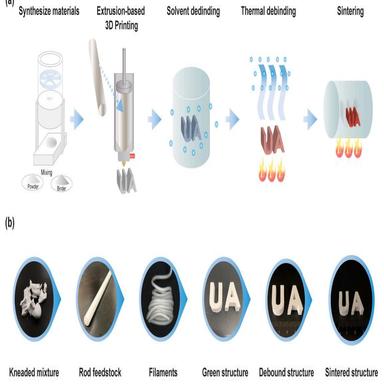
Schematic of entire ceramic additive manufacturing process: (a) Feedstock preparation, piston-based ceramic AM process, solvent debinding, thermal debinding, and sintering process. (b) Kneaded mixture of binder-coated zirconia, rod-shaped feedstock for AM process, extruded filaments, green structure, debound structure, and sintered structure.